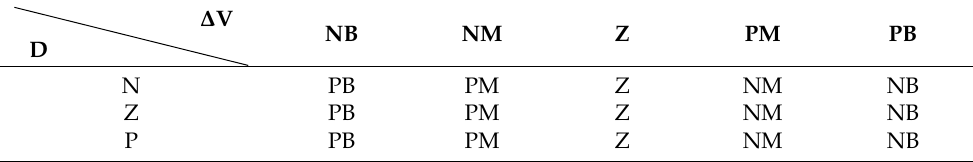
Figure 7. Membership functions of fuzzy controller linear output. Table 2. Membership functions of input and output. ∆V